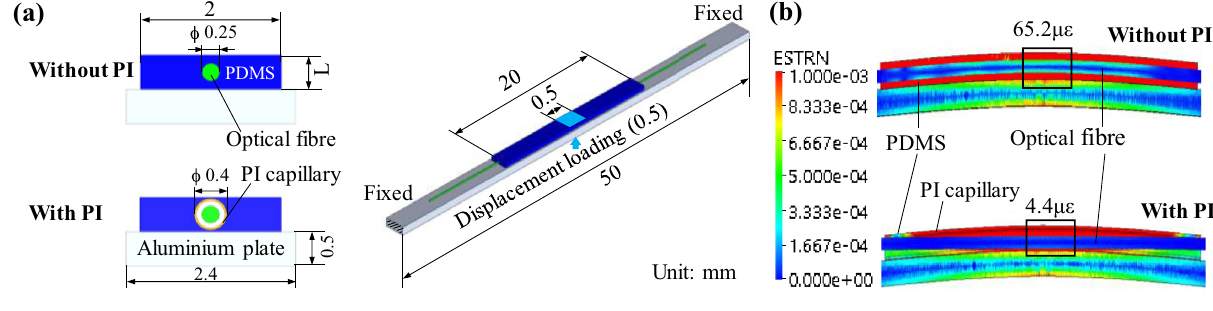
Figure 1. Simulations based on finite element method to analyse the strain transferred from an aluminium plate to the packaged FBG sensor. ( a ) FEM model with dimensions of the simulated structures. ( b ) Results indicating the strain distribution when a vertical displacement of 0.5 mm is applied to the centre of the plate. The colours represent the strain obtained by the simulations in strain (ε)